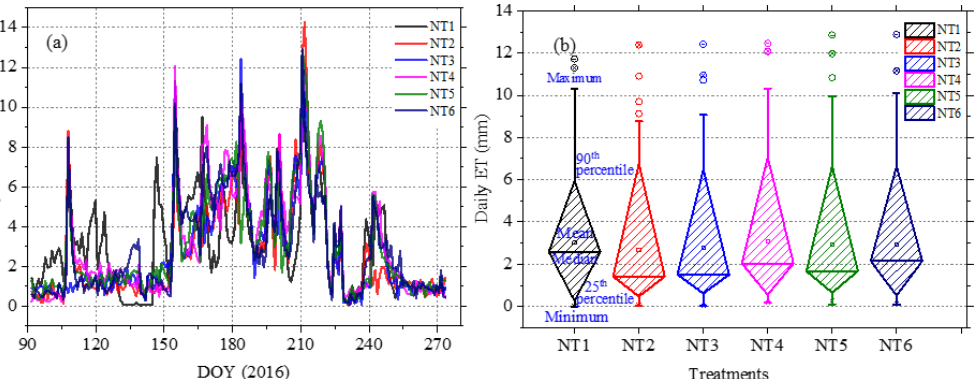
Figure 6. Daily ET during the growing season of 2016 as determined from the inverse Richards method: (a) time series of estimated daily ET; and (b) box-and-whisker diagrams showing the minimum, median, 25th percentile, 75th percentile, and maximum daily ET. No significant differences were detected when Duncan’s multiple range test was applied at the 5% level to compare values among the plots. Note: DOY refers to day of year.